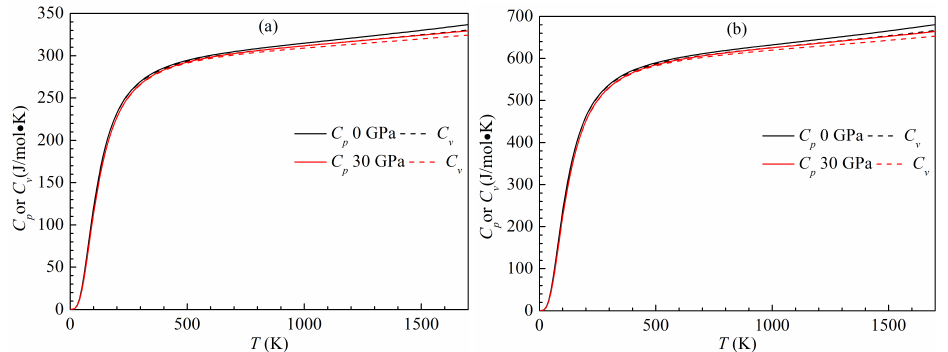
Figure 17. Temperature dependence of heat capacity at constant pressure C p and volume C v for the LPSs ( a ) h- and ( b ) r-Al 2 Ti at 0 GPa and 30 GPa.